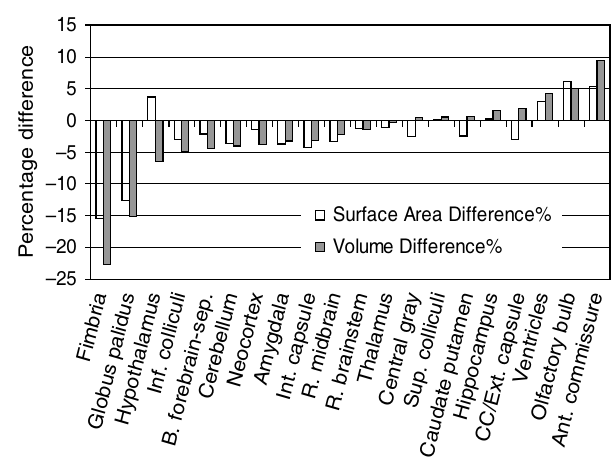
Figure 4. The percentage difference in structural volume and surface area measured from two different resolutions. The percentage differ- ence was calculated as the measurement from the lower resolution scans (100 × 100 × 200 µm 3 , n = 12) subtracted that from the higher resolu- tion scans (100 × 100 × 100 µm 3 , n = 12) and then divided by the former measurement. None of the structural differences were statistically signifi cant (unpaired t -test). The abbreviations used are: Inf. colliculi = Inferior colliculi; B. forebrain-sep = Basal forebrain and septum; Int. capsule = internal cap- sule; R. midbrain = the rest of midbrain; R. brainstem = the rest of brainstem (i.e. pons and medulla); Sup. Colliculi = Superior colliculi; CC/Ext capsule = corpus callosum/external capsule; Ant. Commissure = Anterior